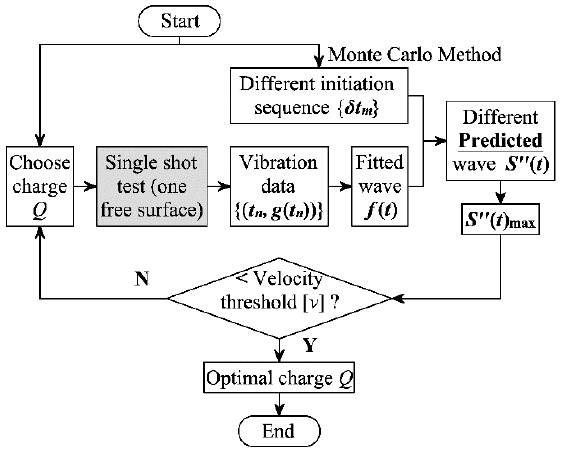
Figure 1. Selection of optimal charge.